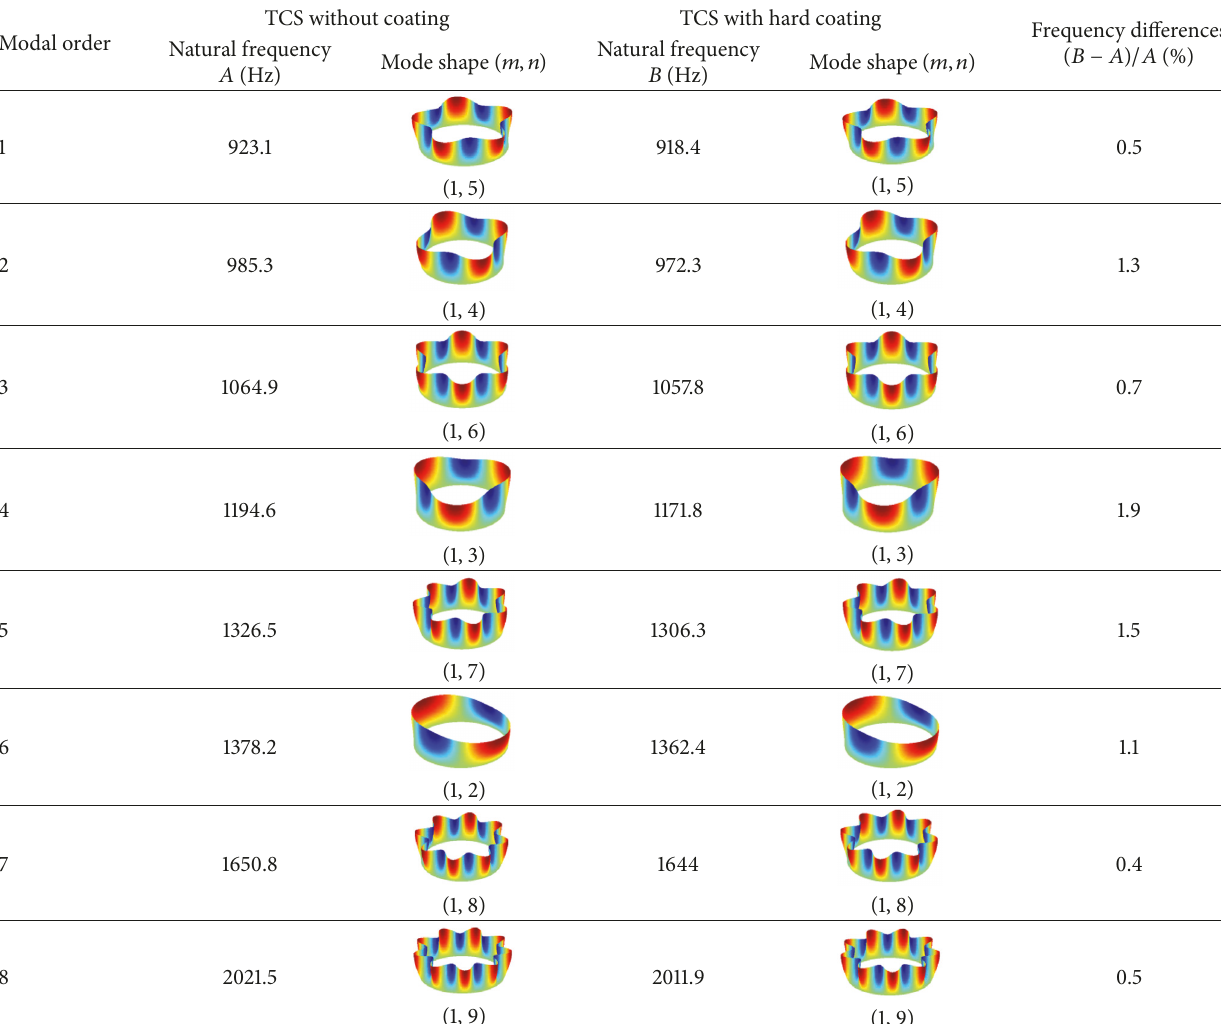
Table 3: The calculated natural frequencies and mode shapes of cantilever cylindrical shell with and without hard coating. Modal